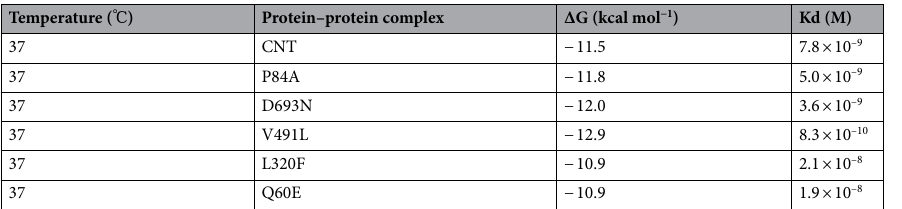
Table 3. Binding affinity of docking complex and its dissociation constant (Kd) at 37 ℃ . The binding affinity and stability of docked proteins are calculated in the form of ΔG (kcal mol −1 ) and Kd (M), respectively. Smaller Kd value is showing high stability and strong binding affinity between two proteins.